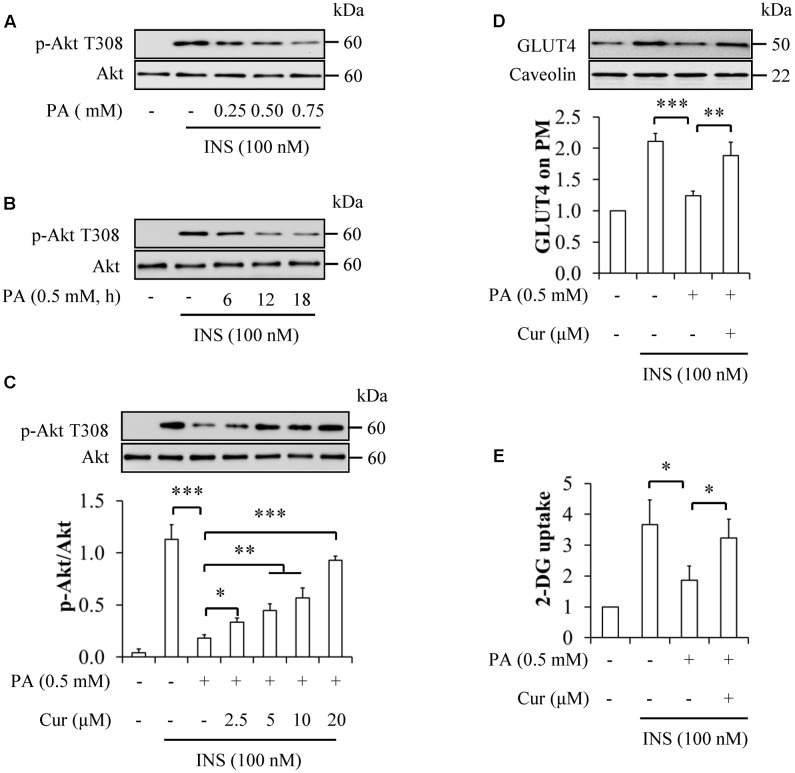
Curcumin mitigated palmitate-induced insulin resistance in HUVECs. (A) Dose-response effect of palmitate (PA) on insulin (INS)-stimulated Akt T308 phosphorylation. (B) Time-response effect of PA on insulin-stimulated Akt T308 phosphorylation. (C) Attenuation of insulin resistance by curcumin (Cur) administration. (D) Effect of Cur on plasma membrane (PM) translocation of GLUT4. (E) Effect of Cur on 2-Deoxy-D-glucose (2-DG) uptake. N = 4. ∗p < 0.05, ∗∗p < 0.01, ∗∗∗p < 0.001 vs. indicated groups.